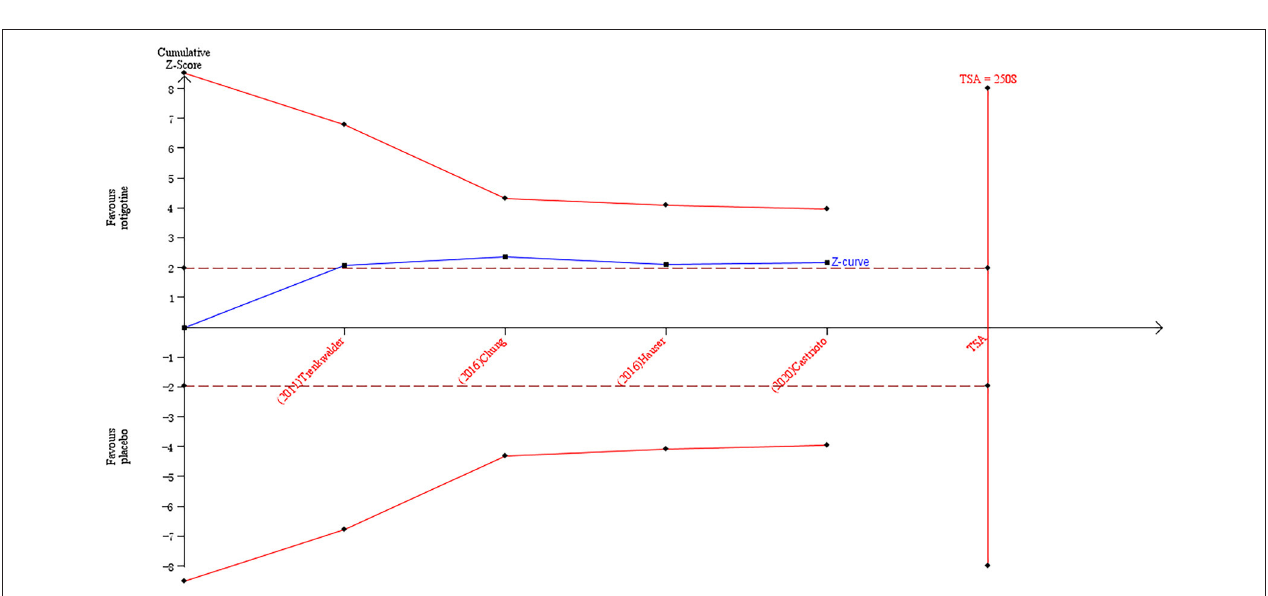
FIGURE 4 | Trial sequential analysis of the cumulative meta-analysis of the effect of rotigotine vs. placebo on BDI-II score in Parkinson’s disease